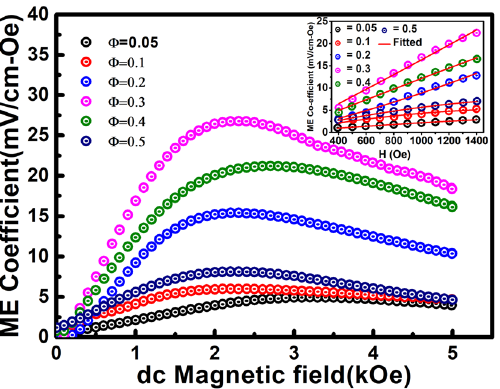
Figure 7. Variation of ME coefficient with applied dc magnetic field for (1 − Φ) PFN-Φ CZFMO composites recorded at RT. Inset shows the fitting of the ME coefficient vs. dc magnetic field below H C using Eq. (6).